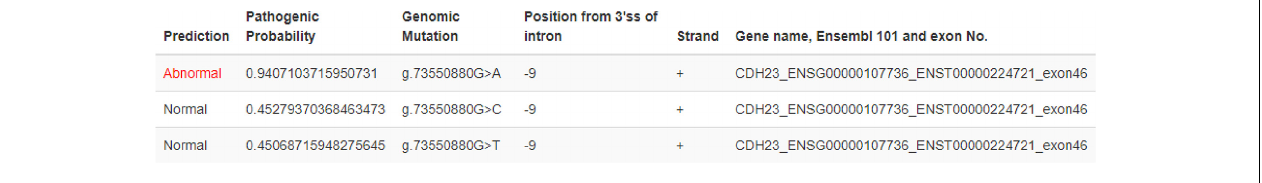
FIGURE 3 | A representative screenshot of the output of IntSplice2 web service. As previously reported, g.73550880G > A on chromosome 10 (GRCh37/hg19) identified in a patient with Usher syndrome is at the ninth nucleotide from the 3’ end of intron 45 of CDH23 . When a user chooses “GRCh37/hg19” and enters the chromosome number “10” and the genomic coordinate “73550880,” the IntSplice2 web service returns the result on the same window on a